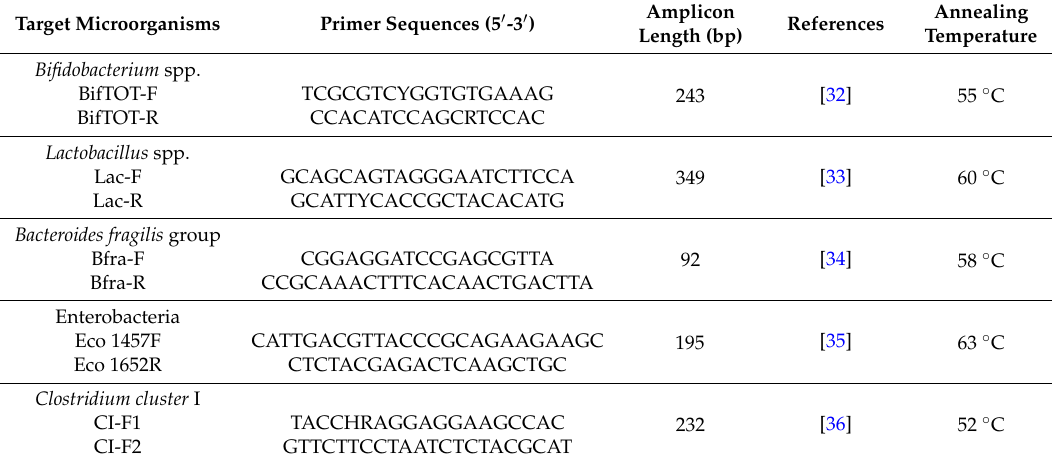
Table 1. Primer sequences and qPCR conditions used in the different assays.